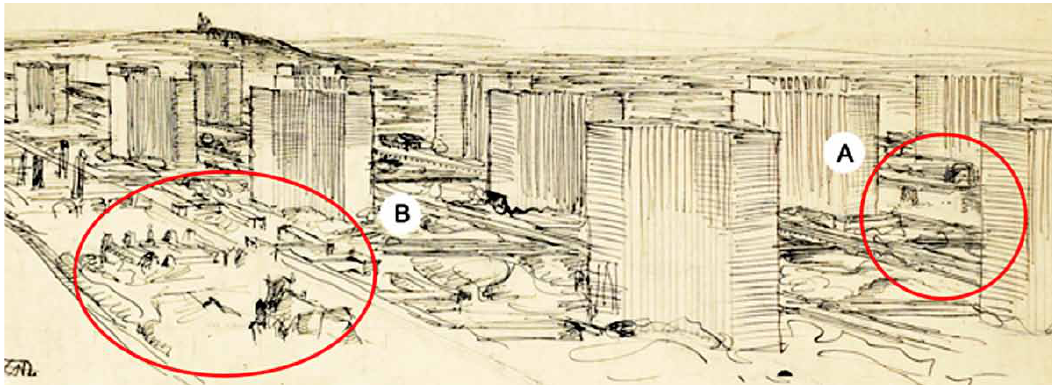
fig. 19. aerial perspective -fragment. flC29721 © flC-aDaGP